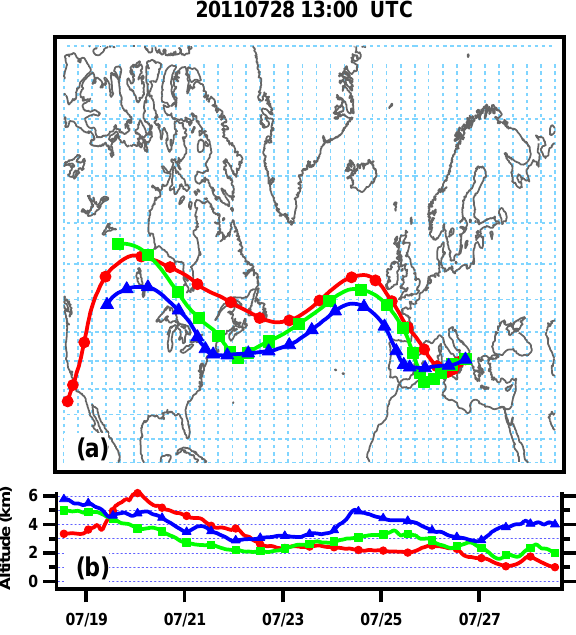
Fig. 4. (a) Pathways estimated at 13:00UTC on 28 July 2011, of the ten day HYSPLIT back trajectories with arrival heights at 1, 2, and 4km a.g.l. (b) Time evolution of the altitude of each back